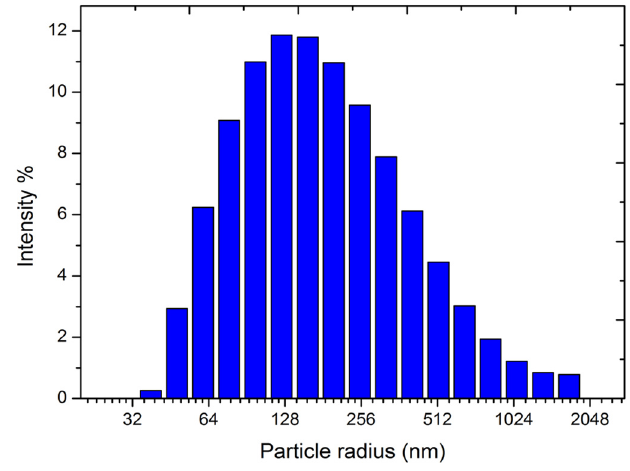
Figure 1. Particle size distribution of BFS.